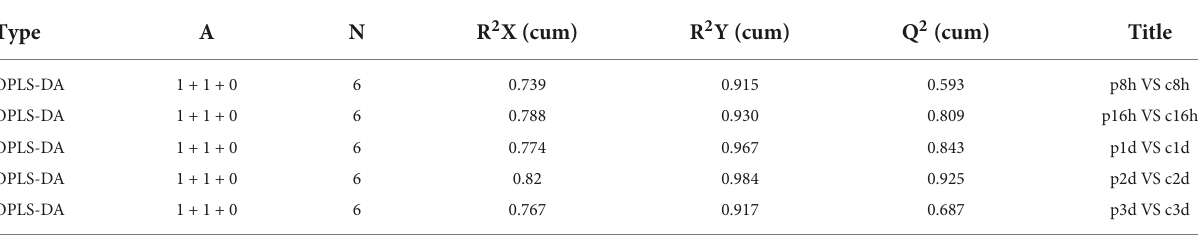
TABLE 1 Cross-validation parameters of the OPLS-DA